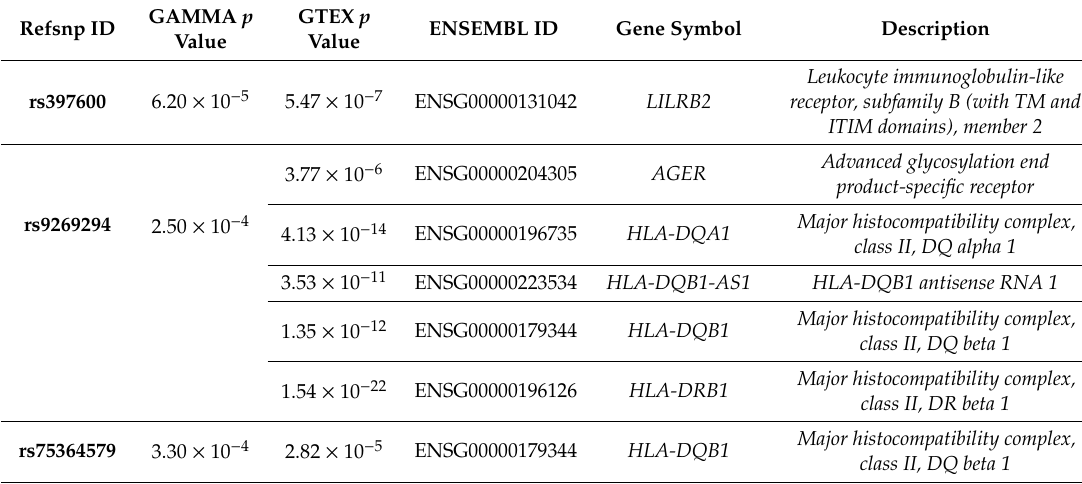
Table 4. SNPs and eGenes significantly detected from sun-exposed skin tissue detected in GTEx version